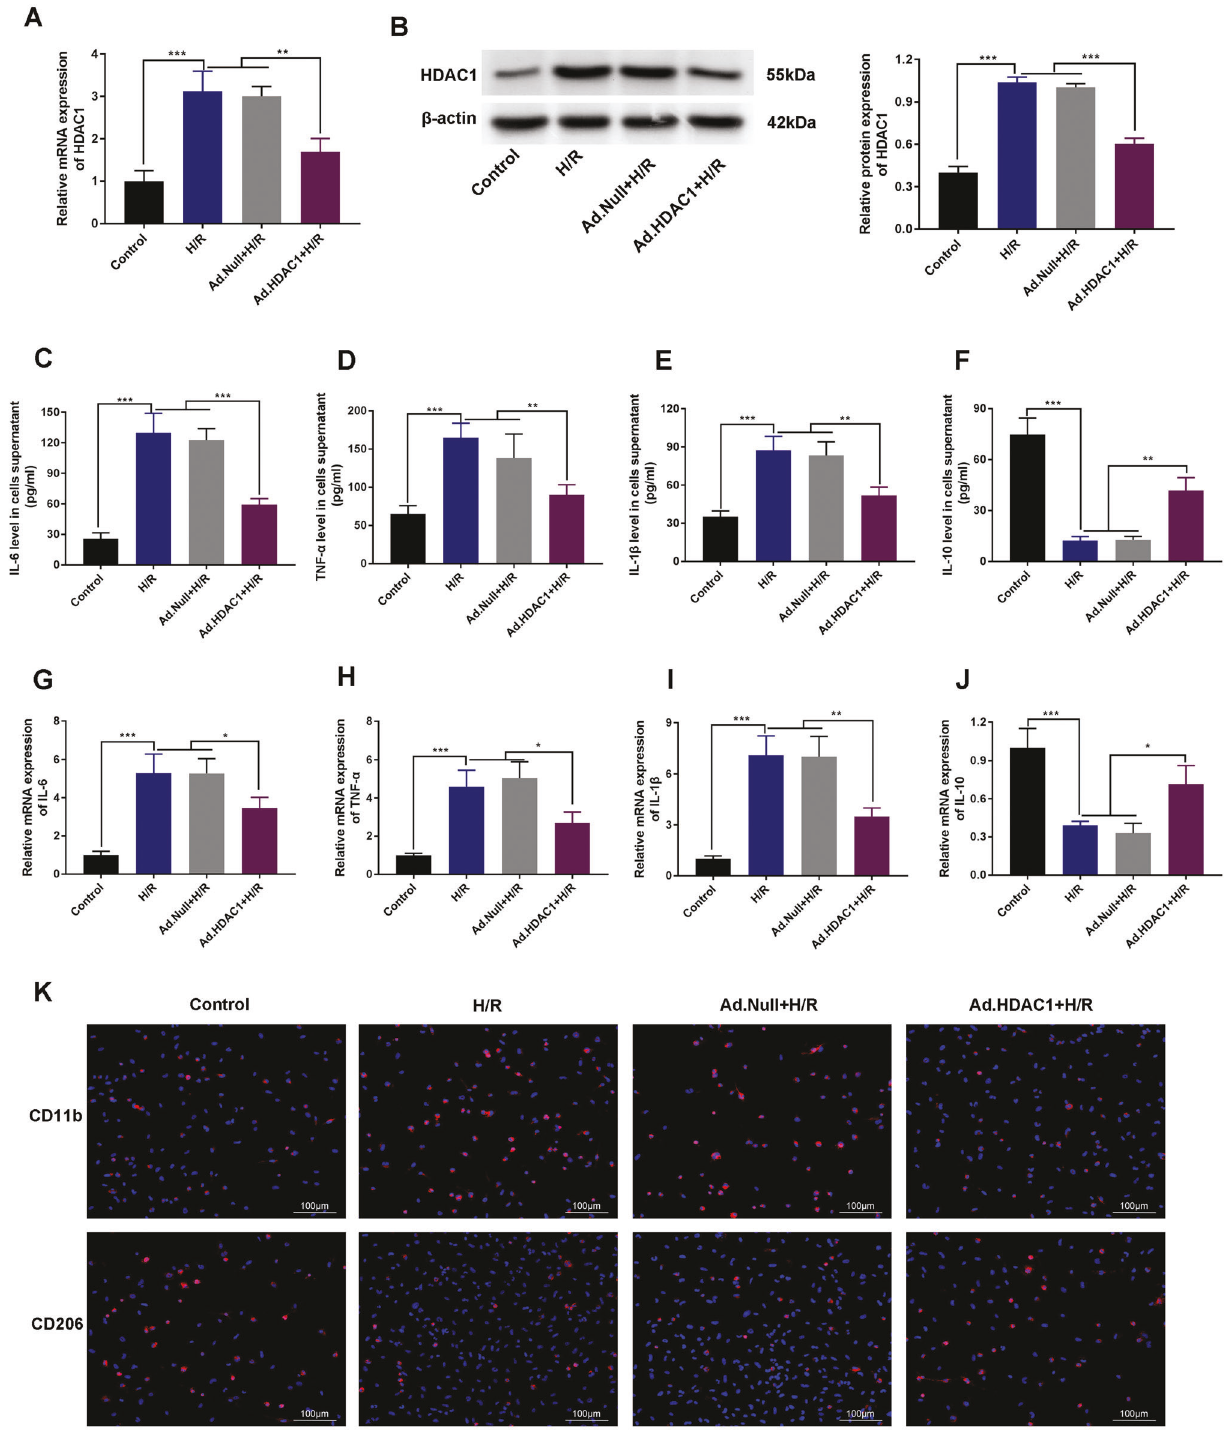
Fig. 2 Inhibition of HDAC1 ameliorates H/R induced in fl ammation in macrophages. A qRT-PCR and B western blot analysis of HDAC1 expression in H/R Raw264.7 cells transfected with Ad.HDAC1. C – F ELISA analysis of cytokine levels. G – J IL-6, IL-10, TNF- α , and IL-1 β gene expression determined by qRT-PCR. K Immuno fl uorescence analysis of CD206 and CD11b expression. n = 3. Data are the mean ± SD. * P < 0.05, ** P < 0.01, *** P < Ad. HDAC1, whilst the levels of IL-10 increased ( P < 0.01, Ad.HDAC1 ( P < 0.01, P < 0.001). ELISA analysis revealed lower P < 0.001). All data were con fi rmed at the mRNA level via qRT- levels of IL-6, IL-1 β and TNF- α and increased levels of IL-10 in PCR analysis ( P < 0.05, P < 0.01, P < 0.001, Fig. 2G – J). Immuno- both H/R and Ad-HDAC1 groups compared to Null + H/R and fl uorescent analysis showed increased expression of CD11b control groups ( P < 0.001; Fig. 2C – F). The levels of IL-6, TNF- α , (a marker of M1 macrophages) and lower levels of CD206 and IL-1 β were signi fi cantly lower in the H/R group treated with